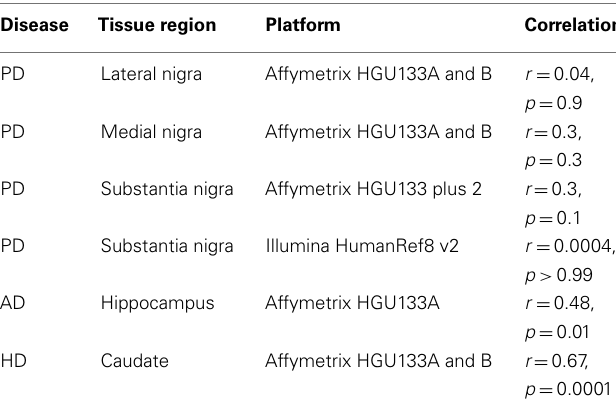
Table 3 | Correlation of X-pattern from whole tissue with neuronal reporter genes.